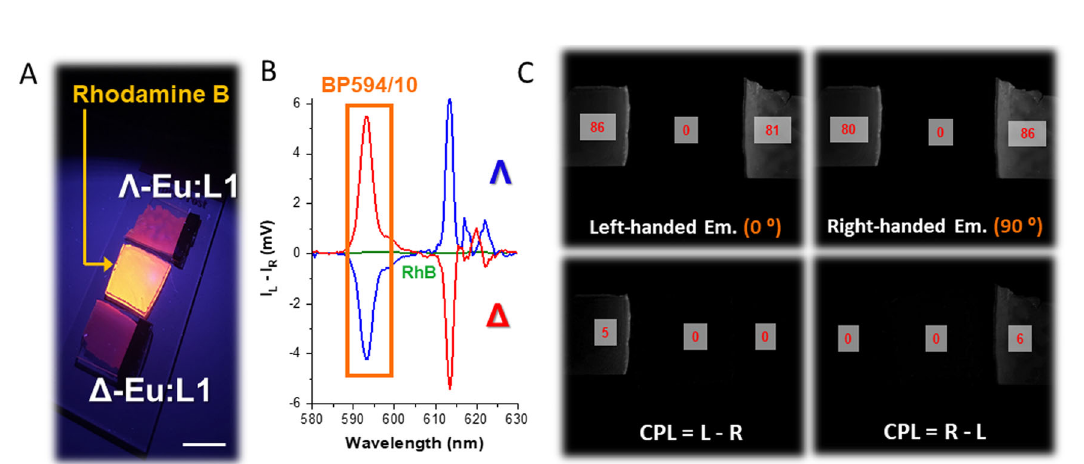
C Time-resolved (t d =20 µ s) Images extracted from the quad polarisation view camera highlighting the recorded total emission, right- and left-handed emission withrespecttothebuilt-inpolariserorientationtothe fi xedQWPfastaxis.Numbers in red are avg. 8-bit pixel intensity values for each image region, t acq. =400ms, 10 avg. image, 100 total image